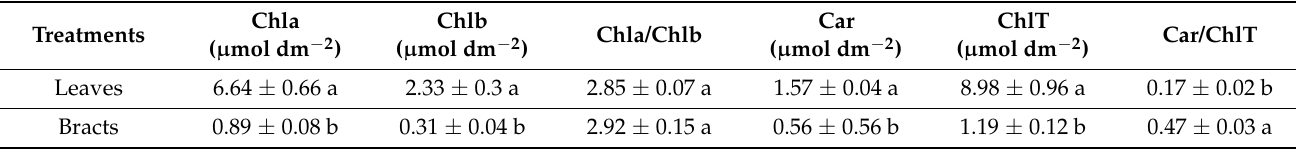
Table 1. The difference of photosynthetic parameter between cotton leaves and